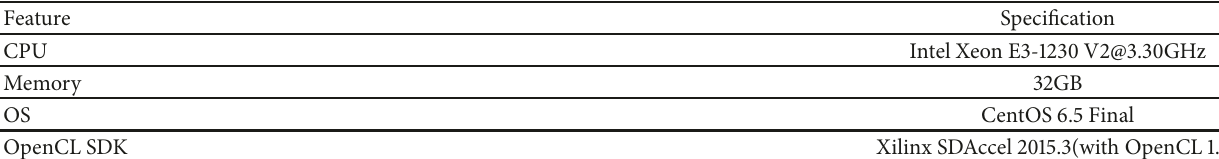
Table 3: The Main Parameters of The